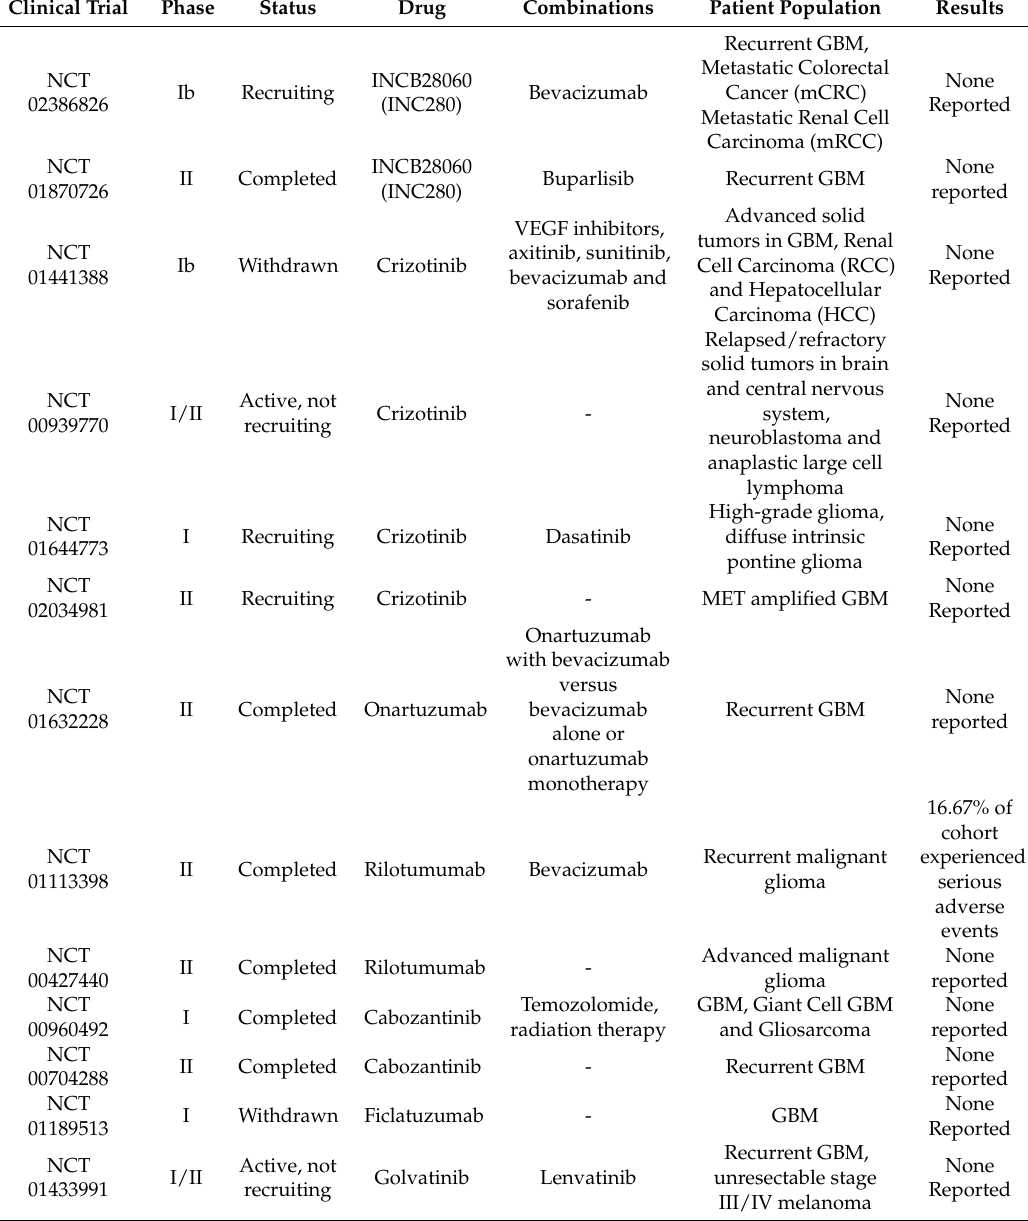
Table 1. Overview of previous and current MET/HGF inhibitor clinical